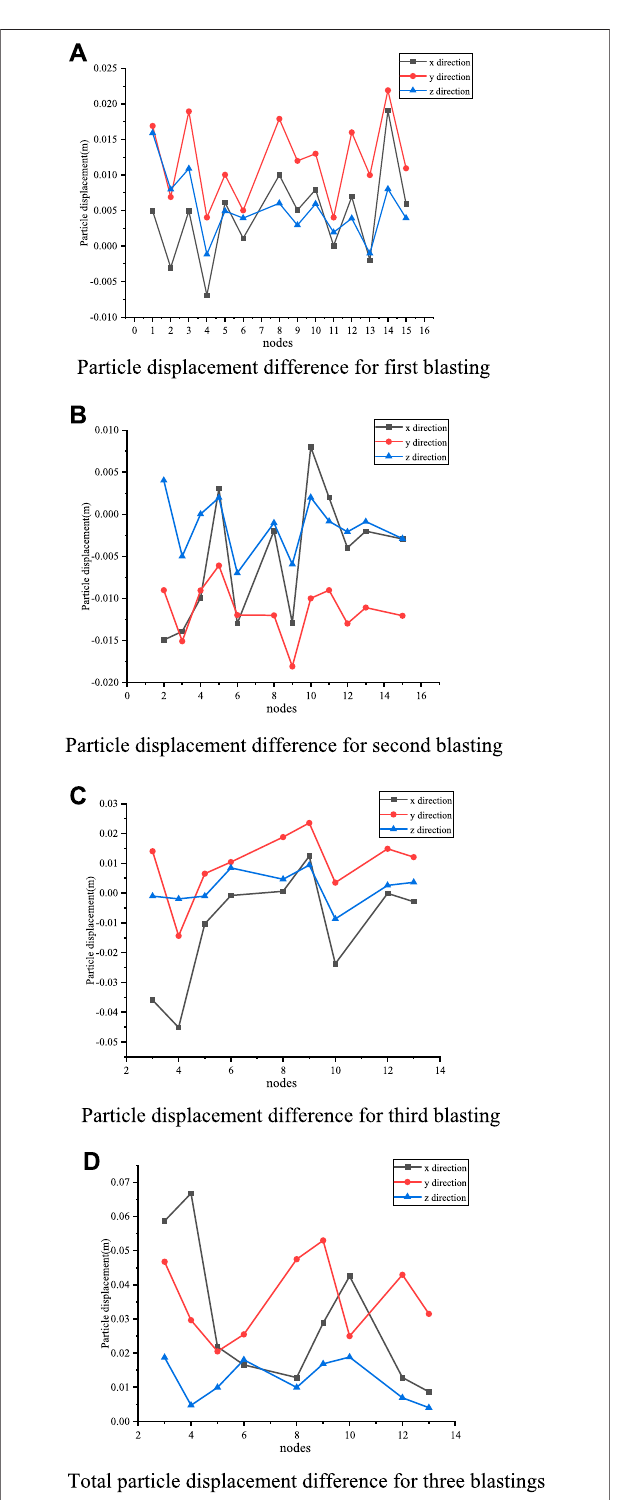
FIGURE 12 | Particle displacement difference of rock wall after three blastings. By analyzing the coordinate data of 15 particles on the back of the rock wall, the following conclusions can be